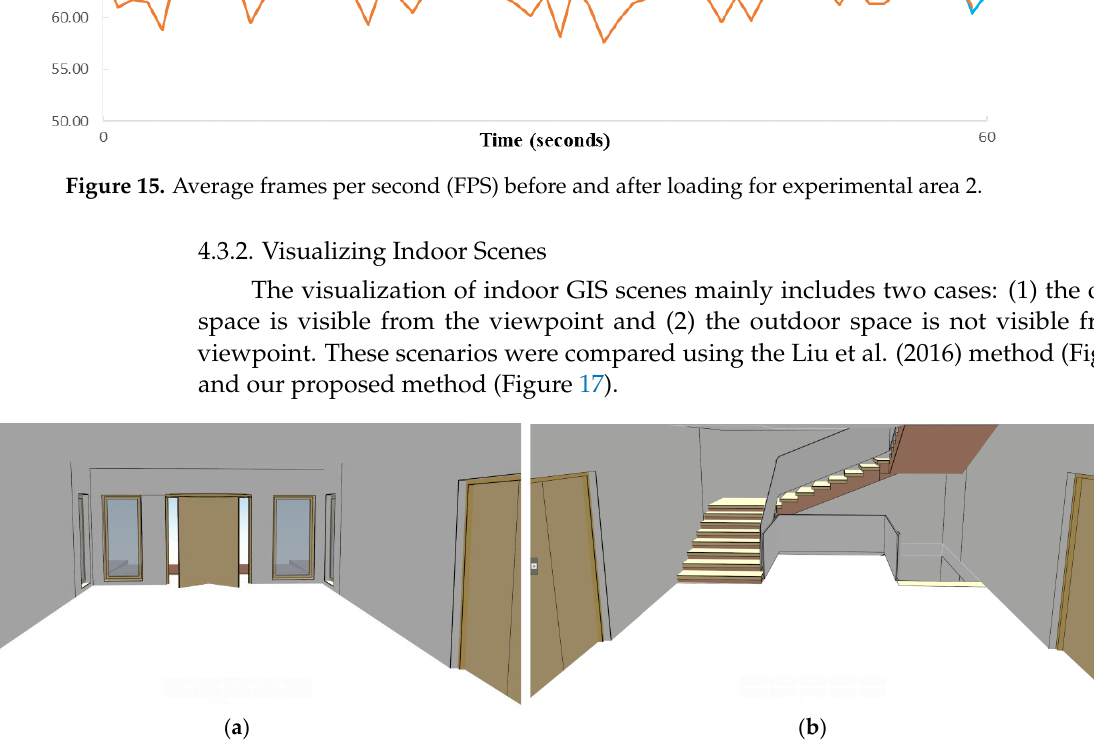
( a ) ( b ) Figure 17. Model output based on the proposed method. ( a ) Visible and ( b ) invisible outdoor scenes. When the outdoor scene is visible, the Liu et al. (2016) method results in an incom- plete and unrealistic environment (Figure 16a), because it removes all outdoor models from indoor views, ignoring BIM/IFC semantics such as IfcWindow and transparency. In contrast, when the outdoor scene is not visible, interior entities are loaded completely (Figure 16b). In contrast, when using our proposed method, visible data (e.g., BIM models and oblique aerial images) were loaded and ensure a realistic environment when the view outdoors is visible (Figure 17a). When there is no view outdoors (Figure 17b), the visuali- zation result is the same as those using the model of Liu et al. (2016). Table 5 compares the statistical results for the different methods when the outdoor scene is not visible. The result proved that our method effectively reduced the geometric information: the building entities decreased by 735, and numbers of vertices and triangles were reduced by 421,176 and 163,963. In summary, our proposed method not only loads visible entities to indoor views, but also effectively reduces the computing burden by re- moving invisible indoor spaces in the building. Table 5. Statistical information for interior building entities when the outdoors is not visible. Experimental Area